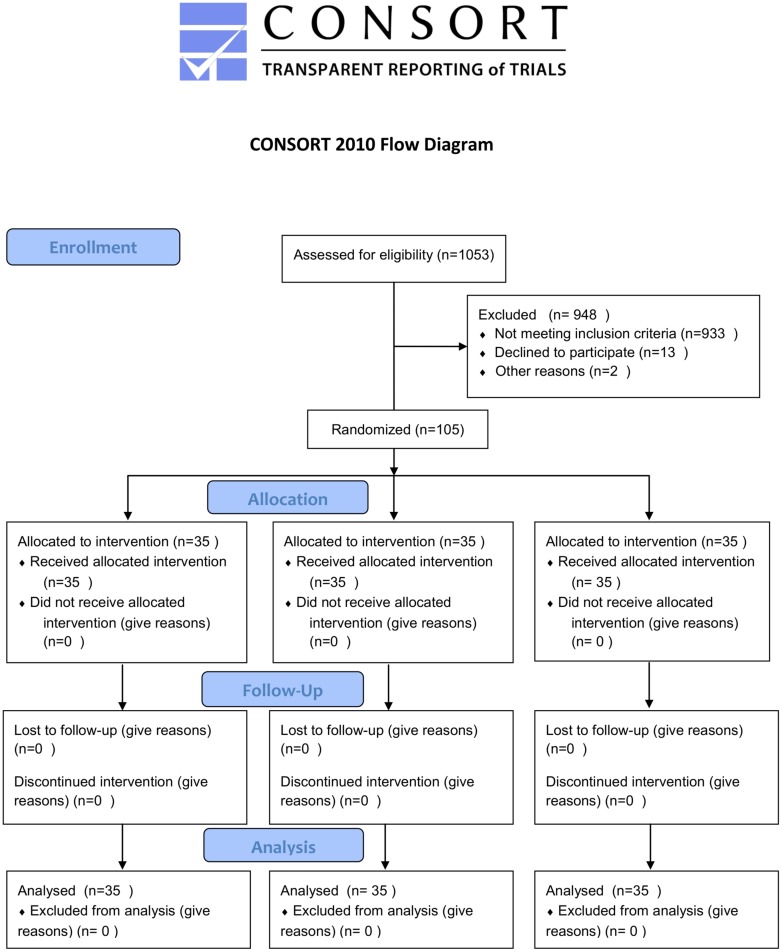
Consort 2010 flow diagram.